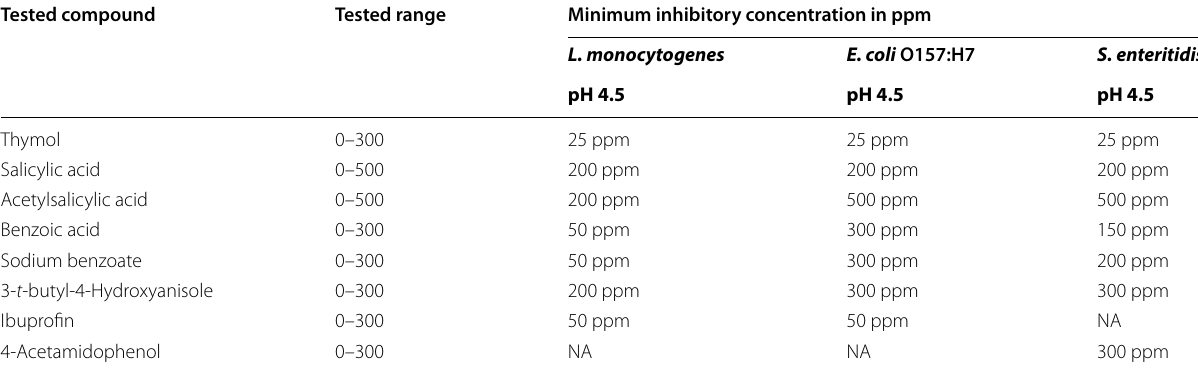
Table 1 Minimum inhibitory concentration of the natural and organic antimicrobials against L. monocytogenes, E. coli O157:H7, and S. enteritidis at pH